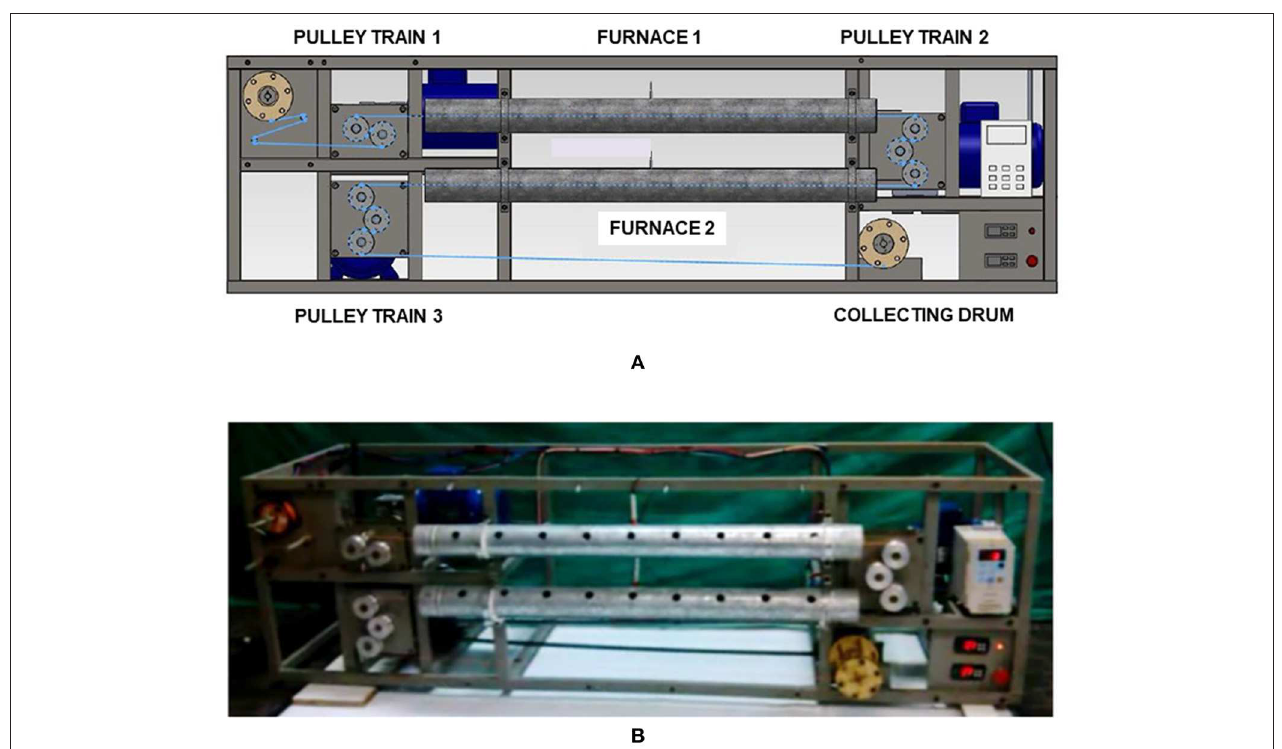
FIGURE 1 | Home-made solid-state drawing machine. (A) Schematic representation and (B)